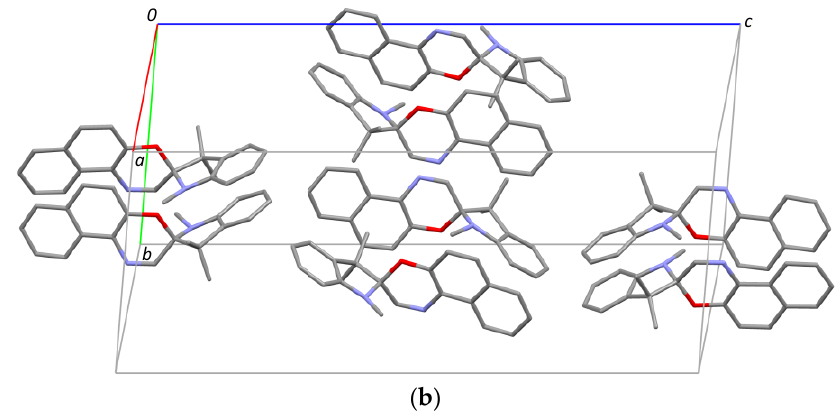
Figure 2. ( a ) A perspective view of (II), showing the atom-numbering scheme. Displacement ellipsoids are drawn at the 50% probability level. Only one of the four molecules in the asymmetric unit is shown. ( b ) A partial packing diagram for (II).